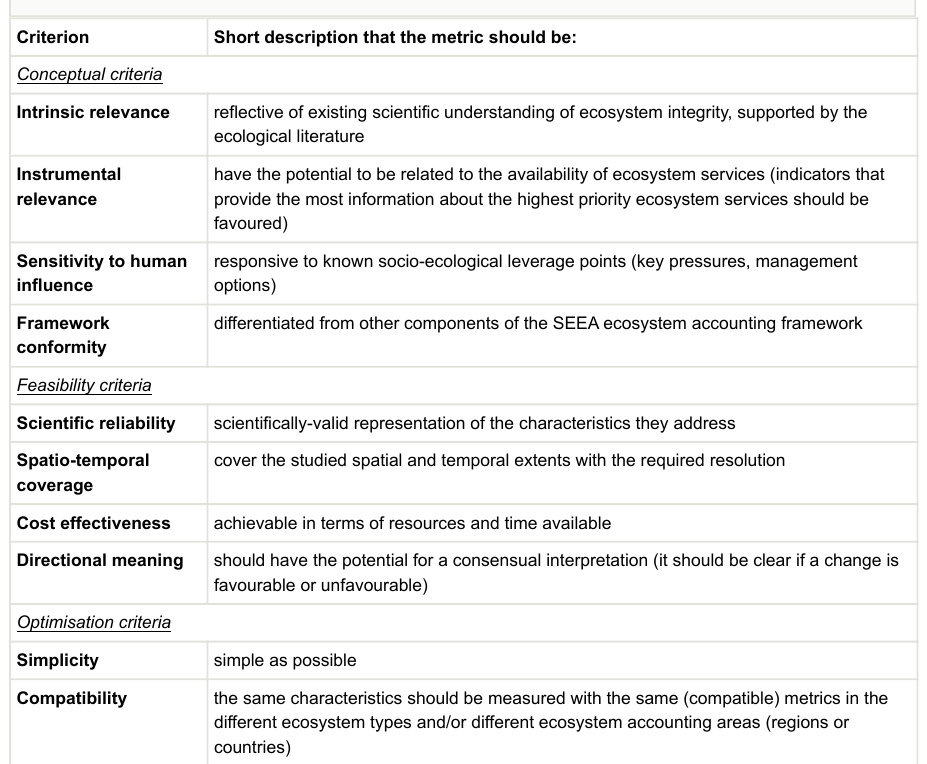
Selection criteria for ecosystem condition characteristics and their metrics (variables and